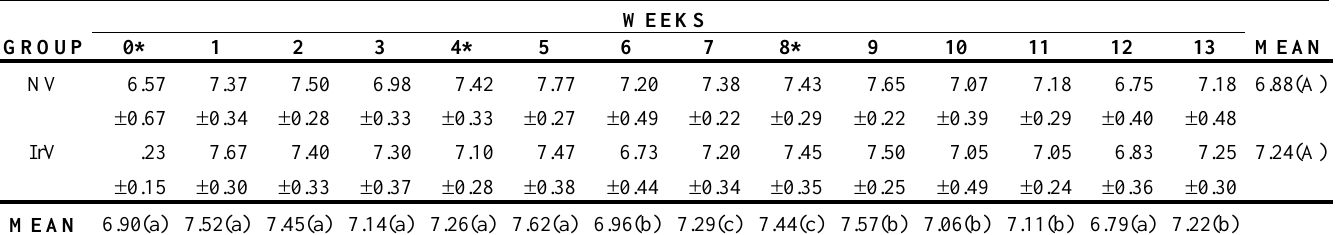
* Inoculations Difference between groups: F=0,16; p>0,50, GI=GII. Difference between times: F= 35,60; p<0,05. Interaction: F= 1.05; p>0.05 Different capital letters show significant statistical differences between groups. Different lowercase letters show significant statistical differences between